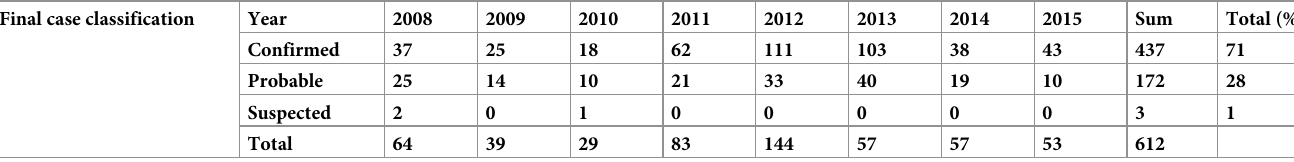
Table 1. Distribution of cutaneous anthrax cases in the country of Georgia by final case classification. Final case classification